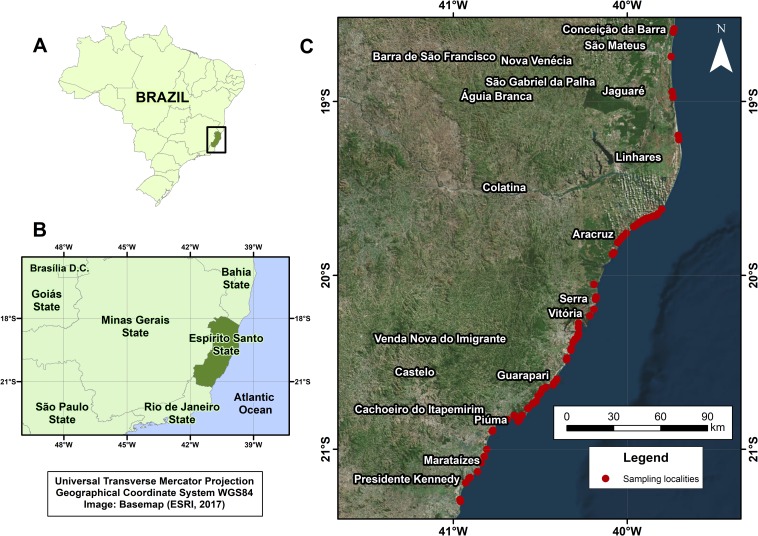
Collection localities of Sotalia guianensis along the coast of the State of Espírito Santo, Brazil.(A) State map of Brazil. The black rectangle indicates the State of Espírito Santo, highlighted in dark green. (B) Zoom in on image map area. (C) Range distribution of the sample localities (red dots). The dashed line represents the South and North State midline with the geographic coordinates set at 20°03'18.8"S 40°11'26.8"W.